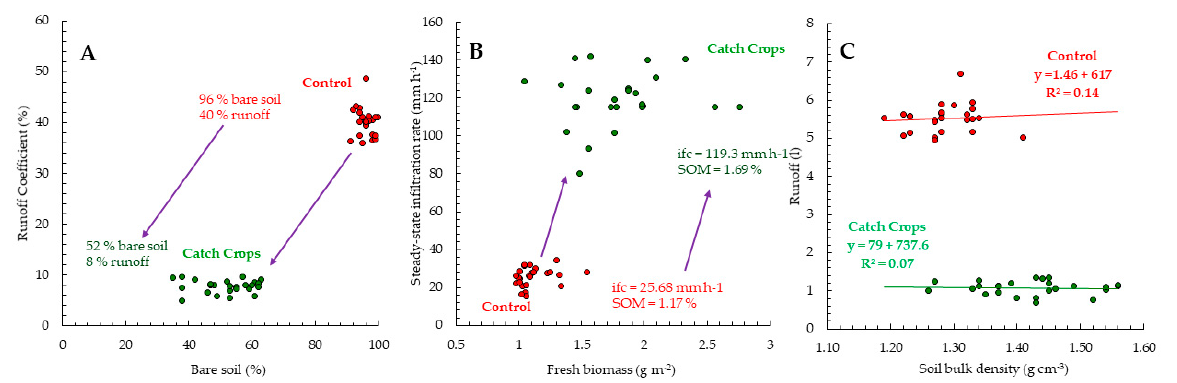
Figure 7. Relationships among variables related to runoff and conditioning factors. A ) Bare soil versus runoff coefficient; B ) fresh biomass versus steady-state infiltration rate; and C ) soil bulk density versus runoff.